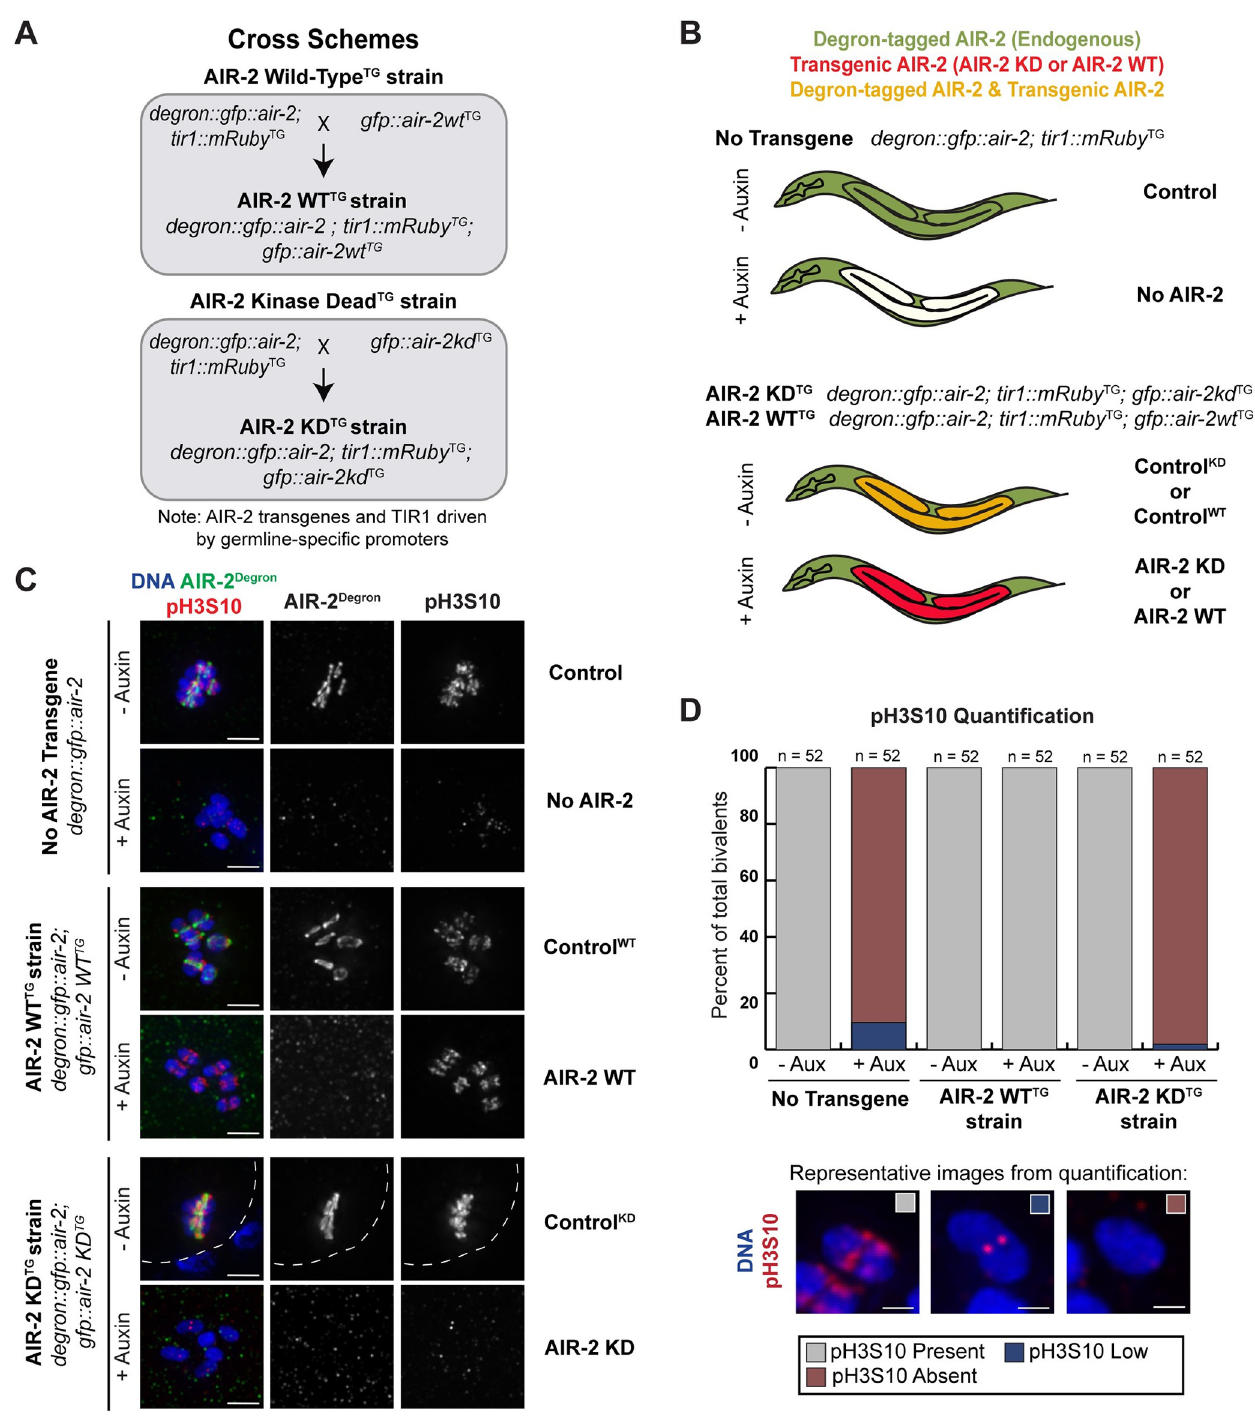
Fig 1. Design and validation of degron-based strategy to analyze Aurora B/AIR-2 kinase activity in C . elegans oocytes. (A) Cross-scheme for strain generation to study the kinase activity of AIR-2. A CRISPR-edited strain containing endogenous AIR-2 tagged with degron :: GFP and with TIR1 expressed in the germ line was crossed with a strain expressing transgenic GFP :: AIR-2 in the germ line. This resulted in a strain that expressed Degron :: GFP :: AIR-2, GFP :: AIR-2, and TIR1 in the germ line. To generate the AIR-2 KD experimental strain, the degron-tagged AIR-2 strain was crossed with a strain expressing kinase-dead GFP :: AIR-2 KD in the germ line. (B) Experimental scheme. Addition of auxin results in germline-specific depletion of endogenous AIR-2, leaving either no germline AIR-2 (“No AIR-2”), or a transgene-expressed version (“AIR-2 KD” or “AIR-2 WT”). (C) The degron antibody (green) was used to